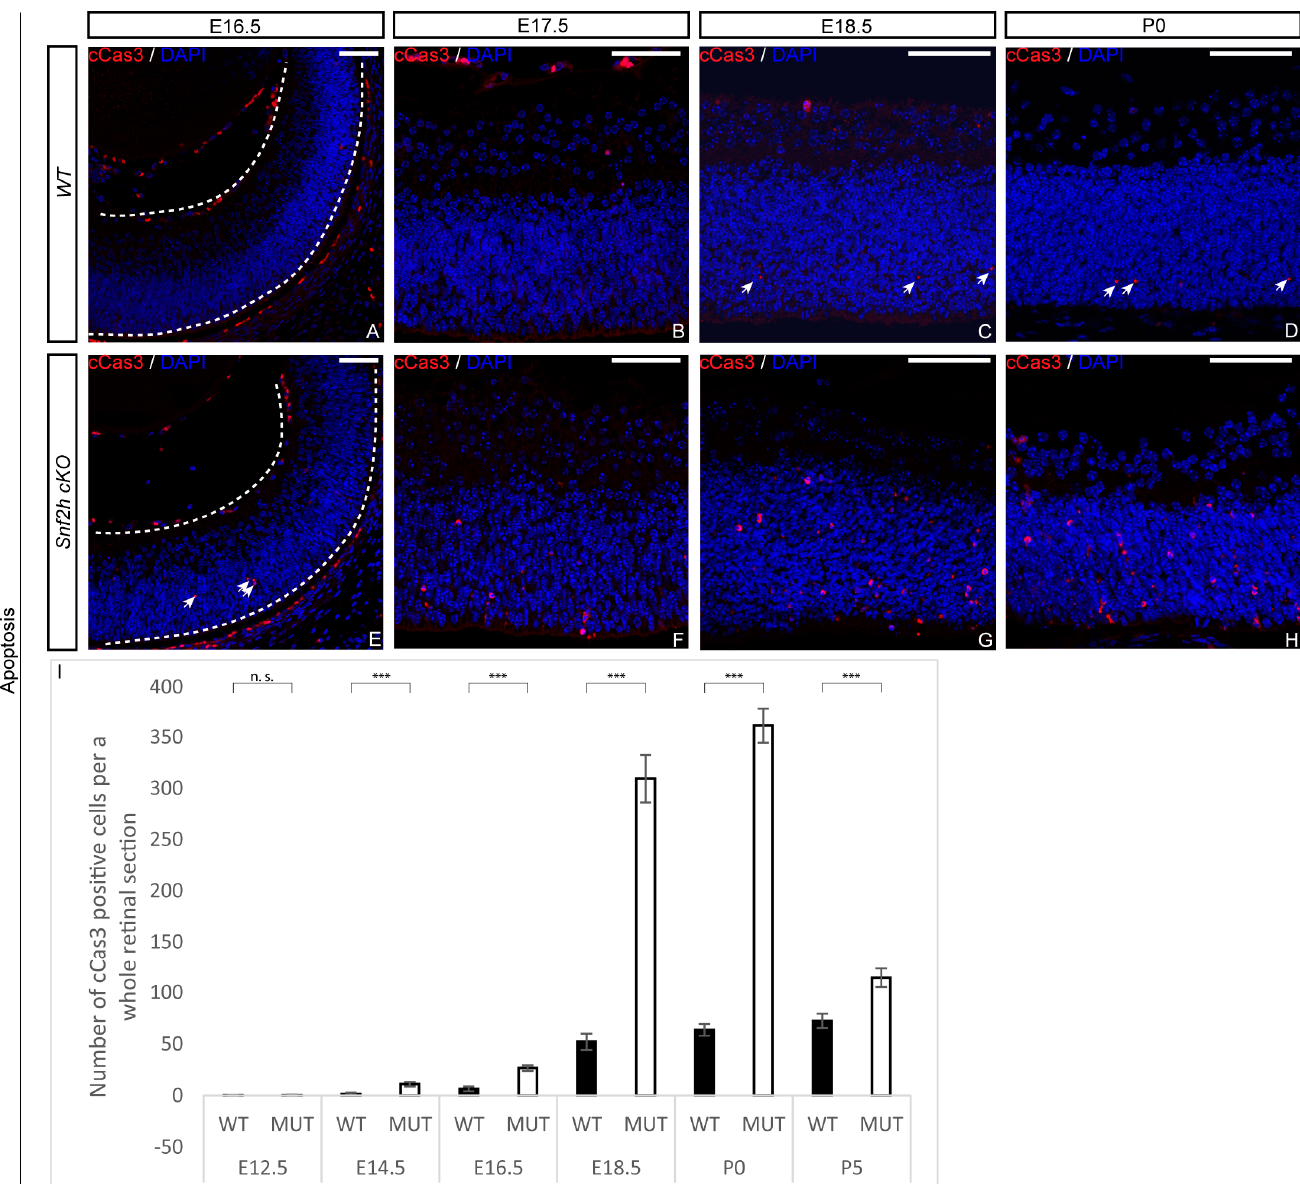
Figure 7. Loss of Snf2h in developing retina is accompanied by massive apoptosis. The number of apoptotic cells in embryonic and postnatal retinae was detected using the anti-cleaved caspase-3 (cCas3) antibody. The differences between Snf2h cKO and controls first appeared at E14.5 ( I ) and gradually increased during later embryonic stages ( A – C , E – G , I ). The peak of apoptosis in Snf2h -deficient mice was at P0 ( D , H , I ). The number of cCas3-positive cells in Snf2h -deficient retinae decreased during the postnatal stages; nevertheless, it remained significantly higher at P5 compared with wild-type controls ( I ). Error bars indicate standard derivation; p -values were calculated using Student’s t -test ( n = 4). *** p < 0.001, n.s. = not signi fi cant. White arrows indicate cCas3-positive cells. Scale bars: 50 m.